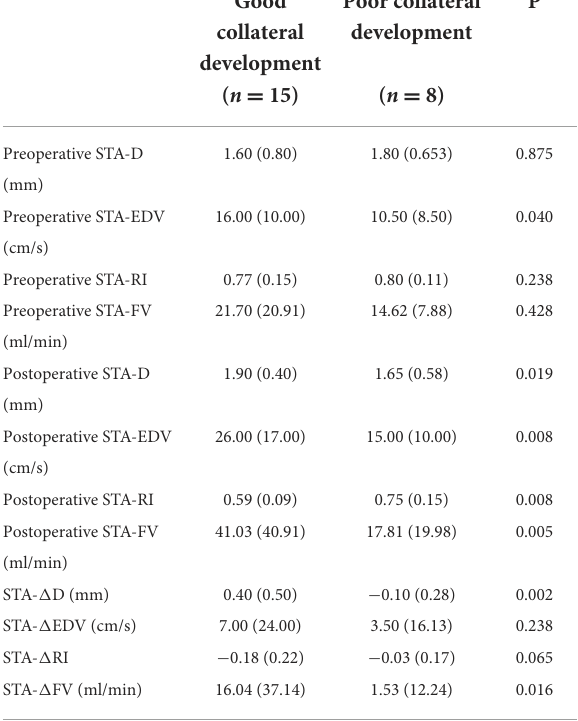
TABLE 5 Differences in STA ultrasound parameters between good and poor collateral development groups after EDAS. Good